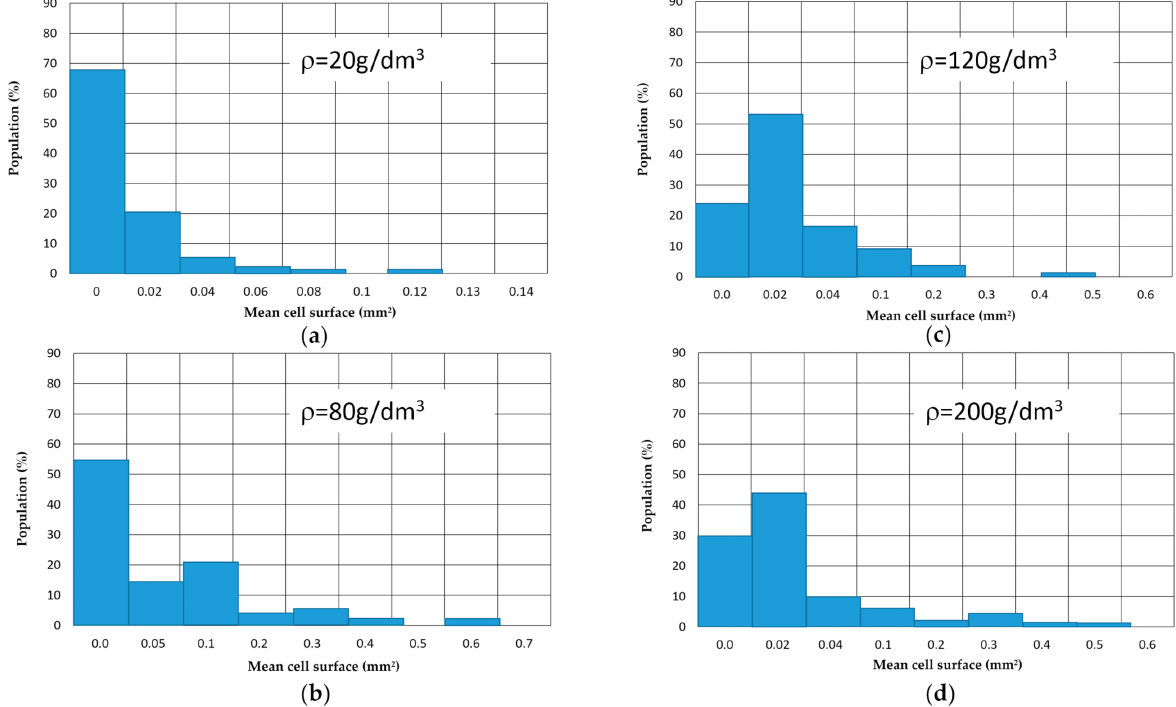
Figure 2. Representative measurement of average cell dimension ( a ) cell surface ρ = 20 g/dm 3 ( b ) ρ = 80 g/dm 3 ( c ) ρ = 120 g/dm 3 ( d ) ρ = 2000 g/dm 3